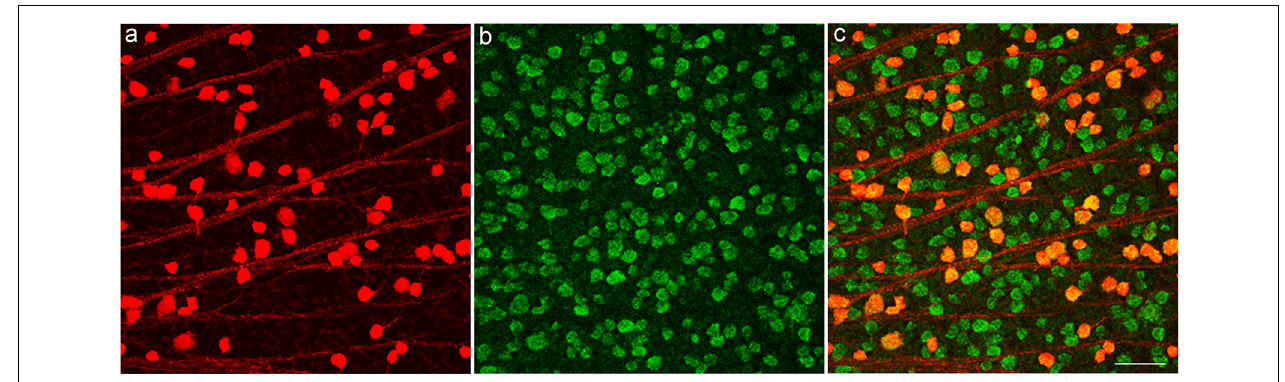
FIGURE 3 | TdTomato fluorescent cells in GCL of a PV- Pten +/- mouse retina express the ganglion cell marker, RNA binding protein with multiple splicing (RBPMS). (A) TdTomato fluorescent ganglion cell bodies. (B) RBPMS-immunoreactive ganglion cell bodies in the GCL. (C) Merged images show that tdTomato fluorescent cell bodies contain RBPMS immunoreactivity. z-step = 1 µ m. Three optical sections were compressed for viewing. Scale bar: 50 µ m.